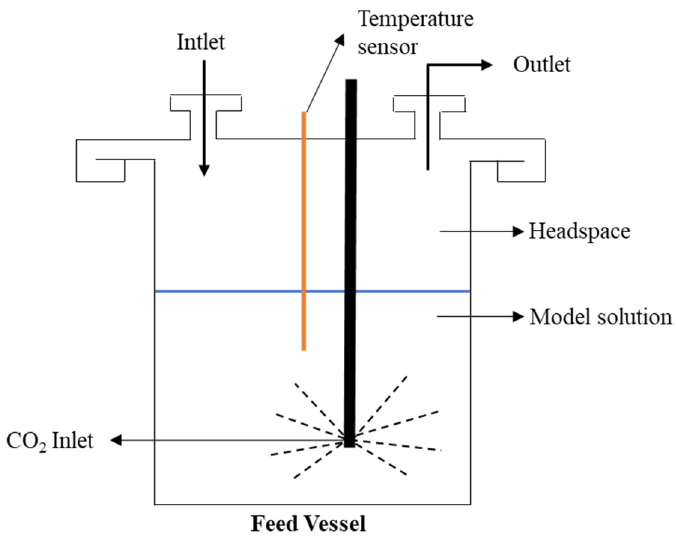
Figure 3. Scheme of the feed vessel.